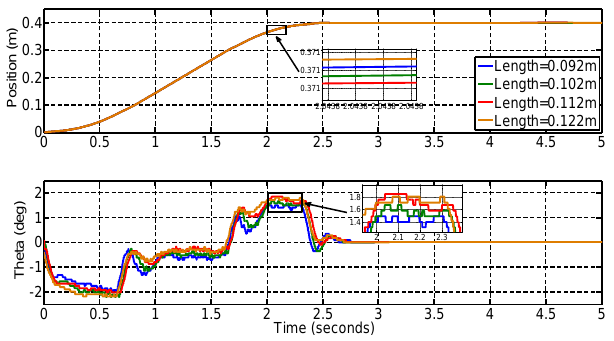
Figure 14. The response in different cable lengths.